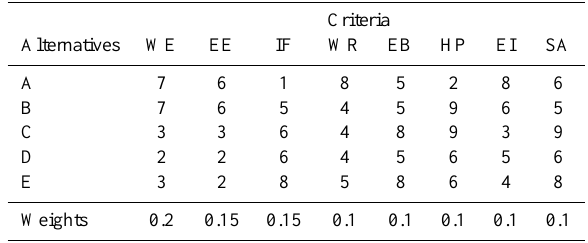
Table 1. Initial Matrix for La Estrella sub zone, for